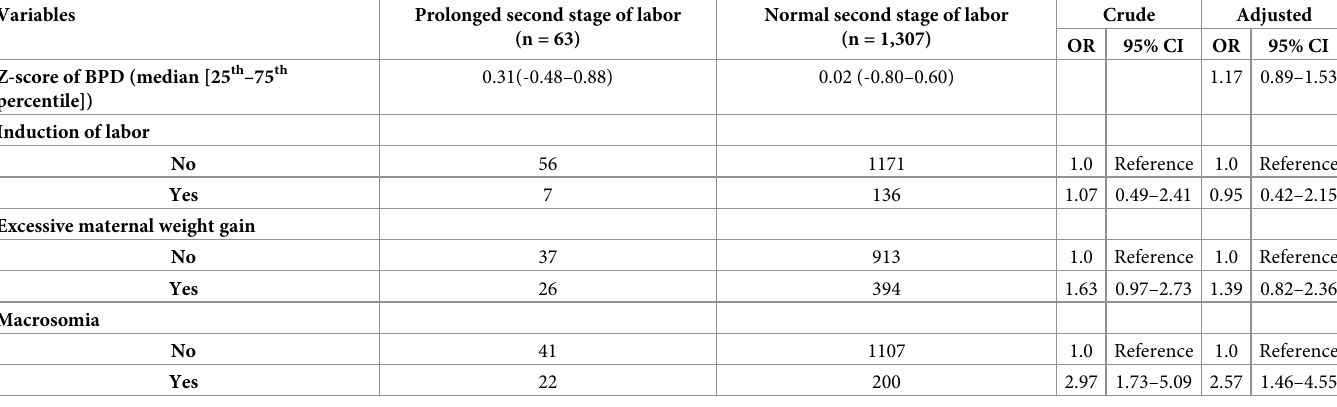
Table 8. Factors associated with prolonged second stage of labor in multiparous women.